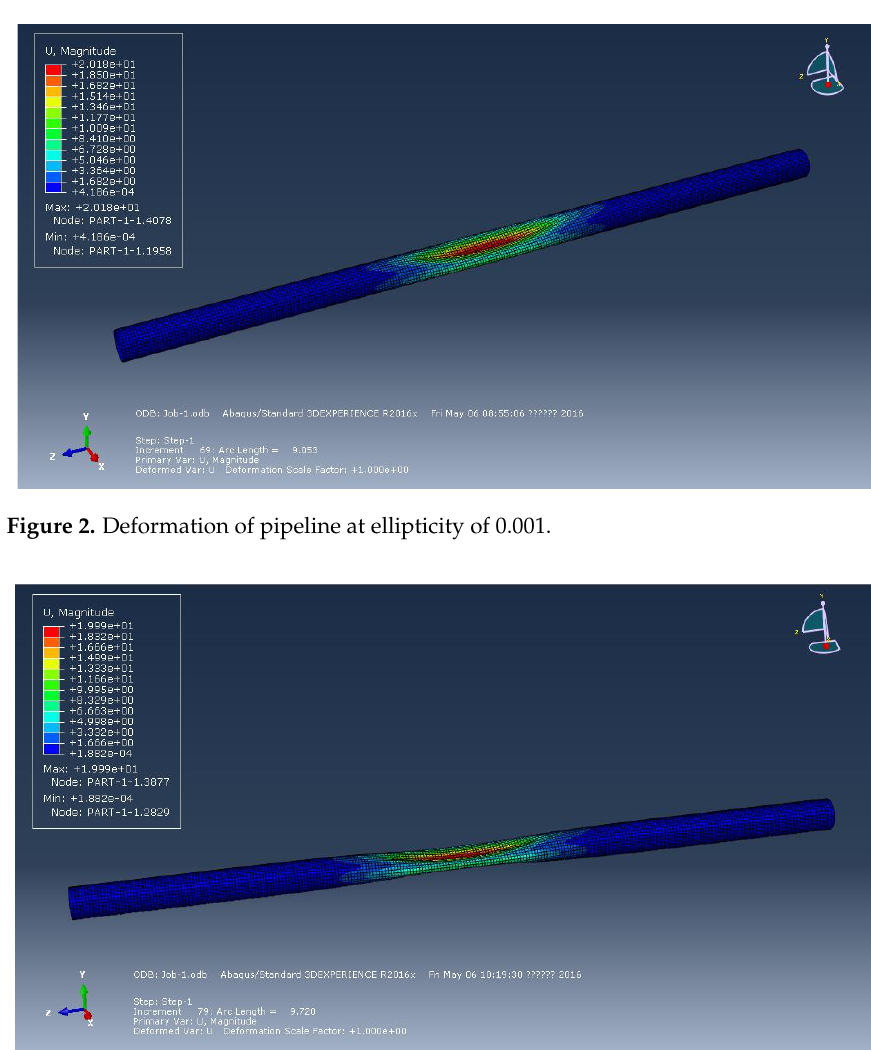
Figure 3. Deformation of pipeline at ellipticity of 0.01.